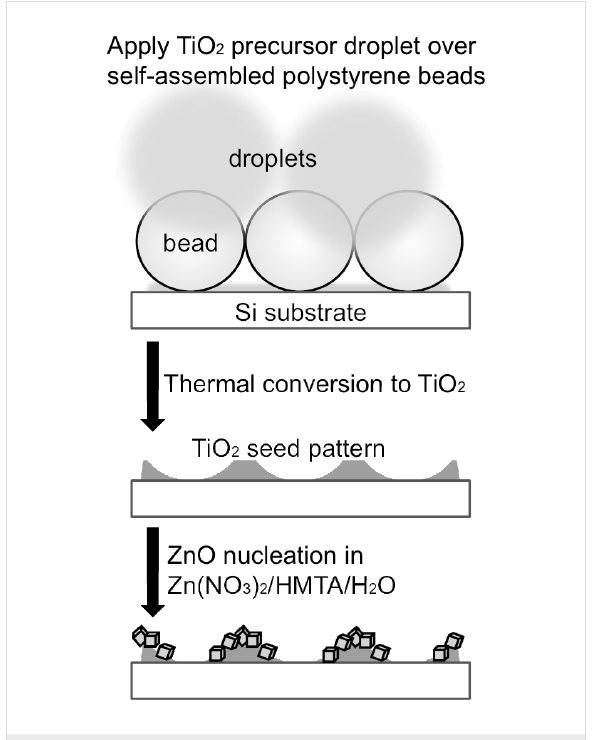
Figure 1: Step-by-step representation of a PSL/m-CVD approach to the patterned nucleation of ZnO nanocrystal clusters.